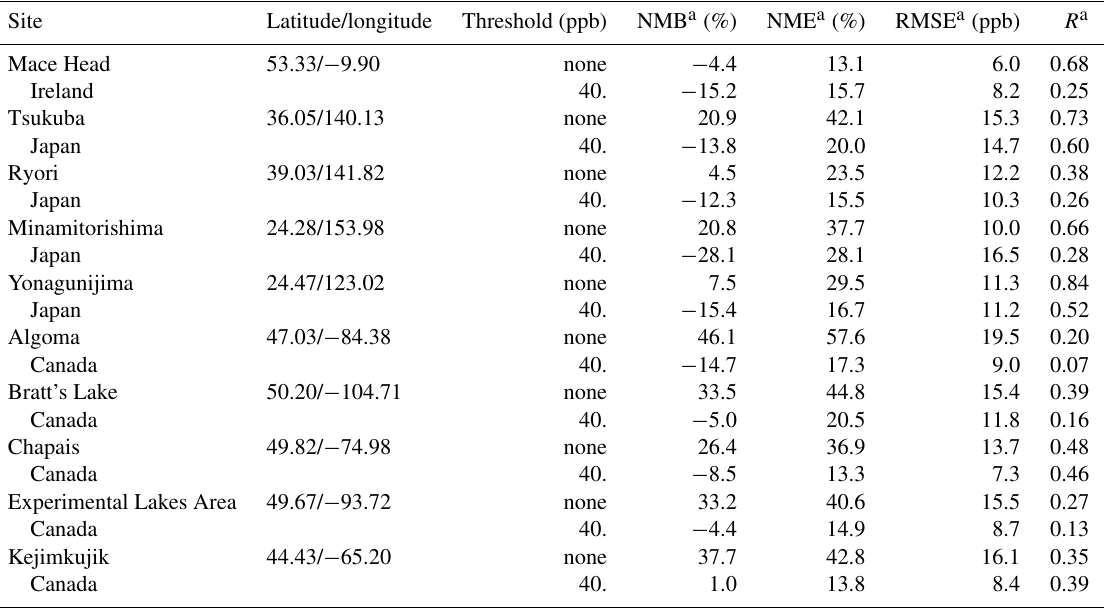
Table 2. Model performance metrics for hourly O 3 from the GEOS-Chem base case for the March–September 2010 period with zero or 40ppb thresholds for the observed